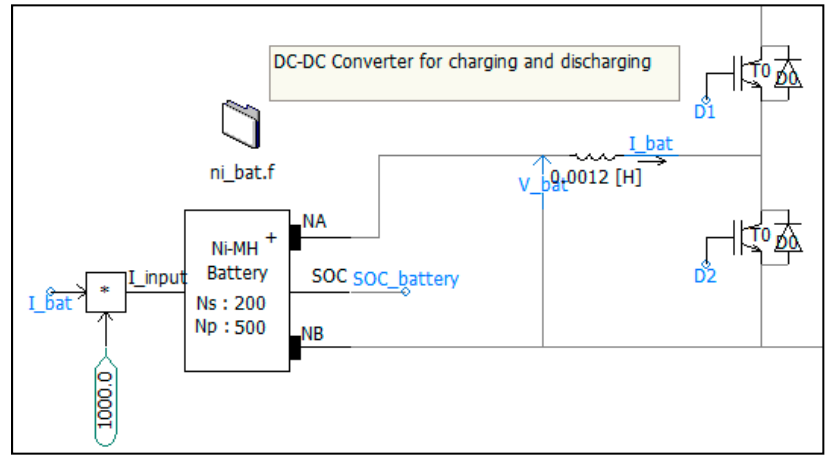
Figure 27. Battery and bidirectional DC/DC Converter in PSCAD.